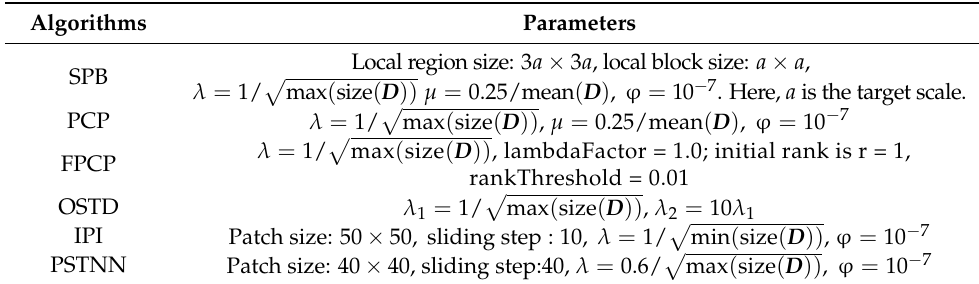
Table 2. The parameters of 6 algorithms.